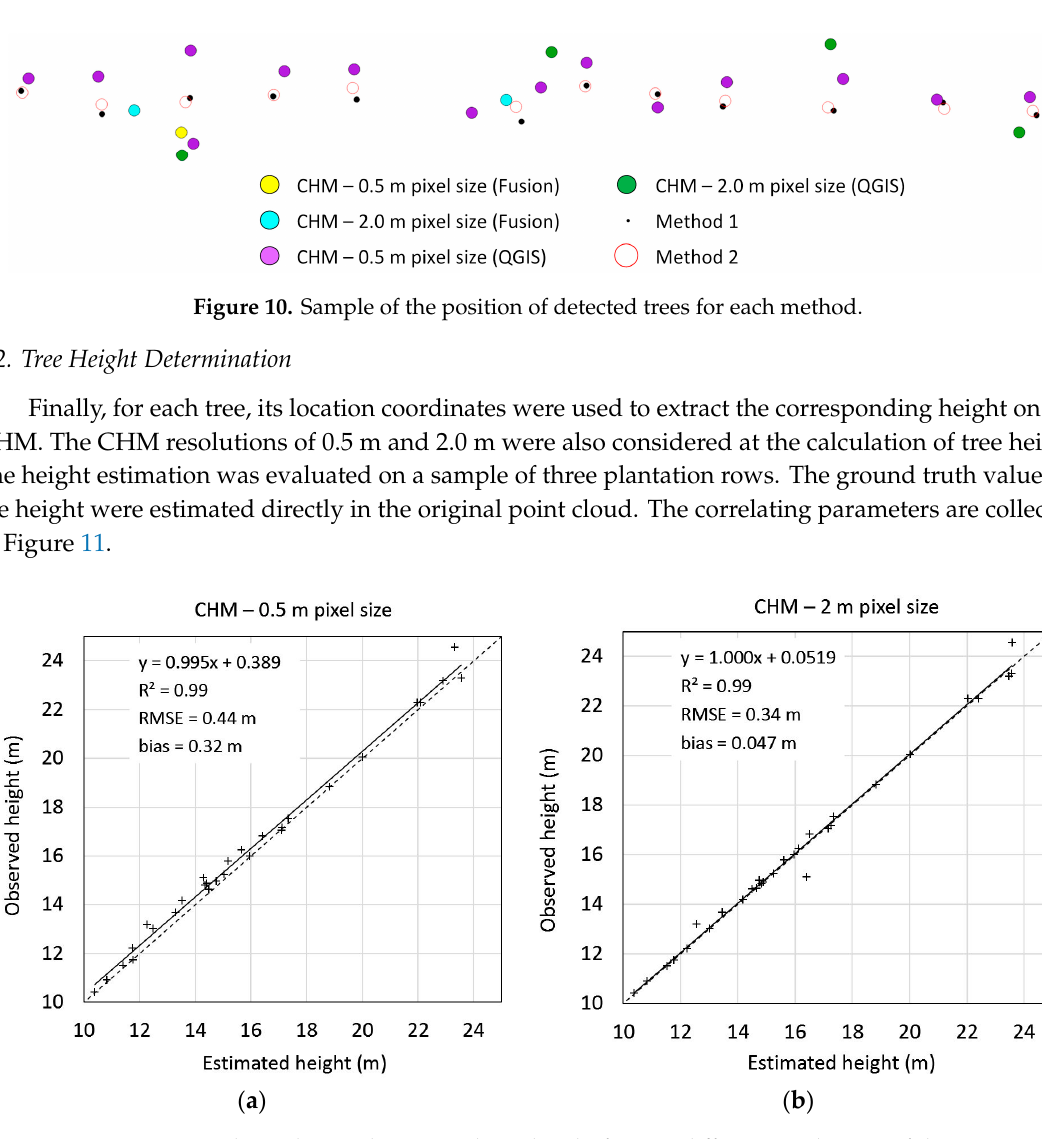
Figure 9. False negative due to a merge of buffers.